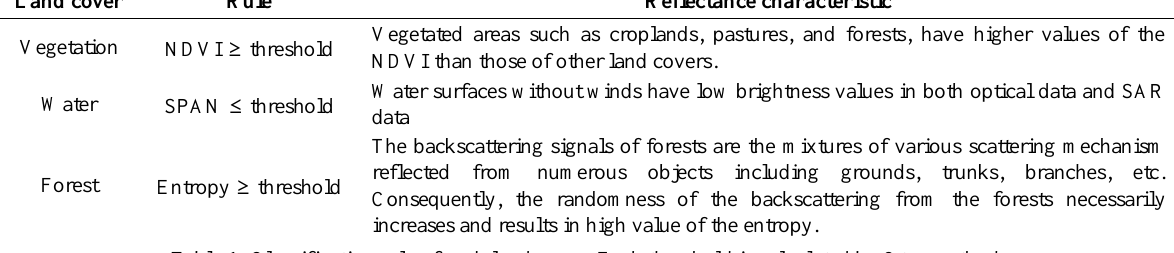
Table 1. Classification rule of each land cover. Each threshold is calculated by Otsu method.